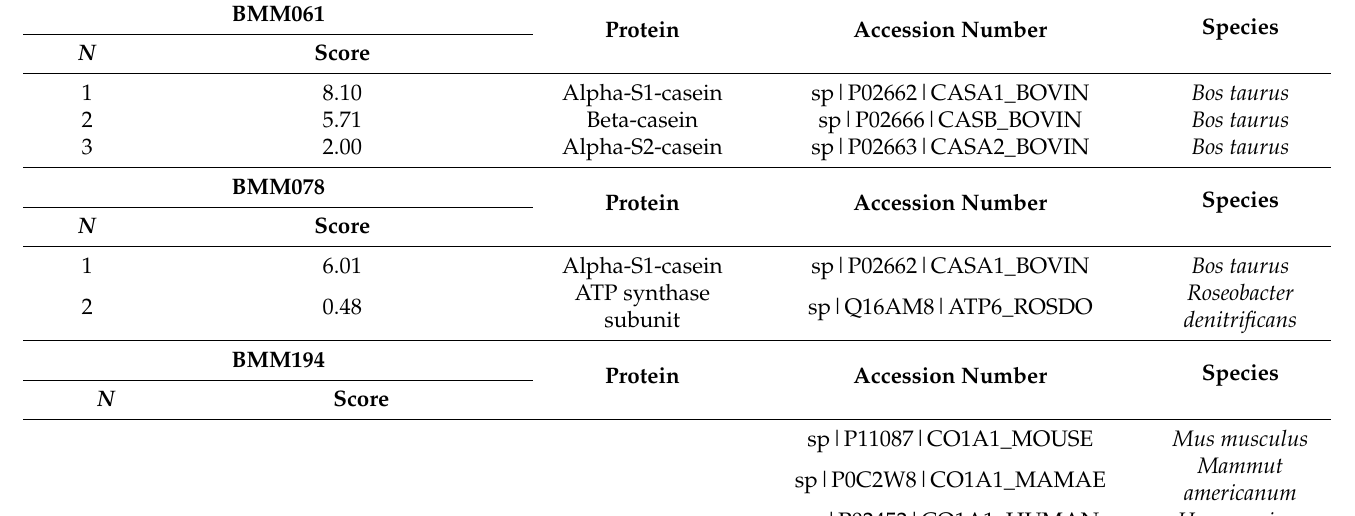
Table 7. Results from the database search for proteins.